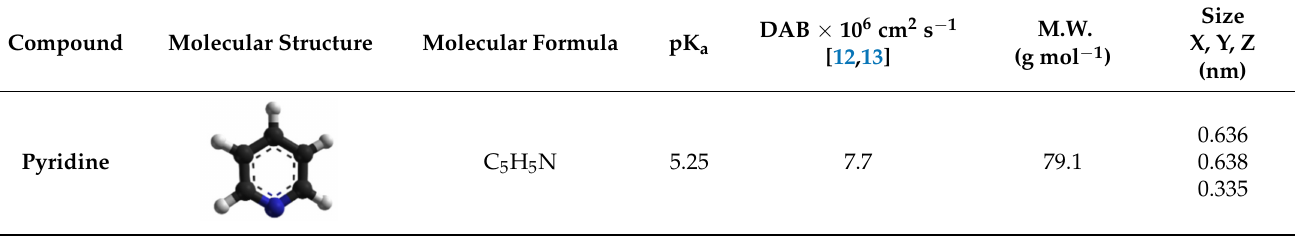
Table 1. Physicochemical properties of pyridine.